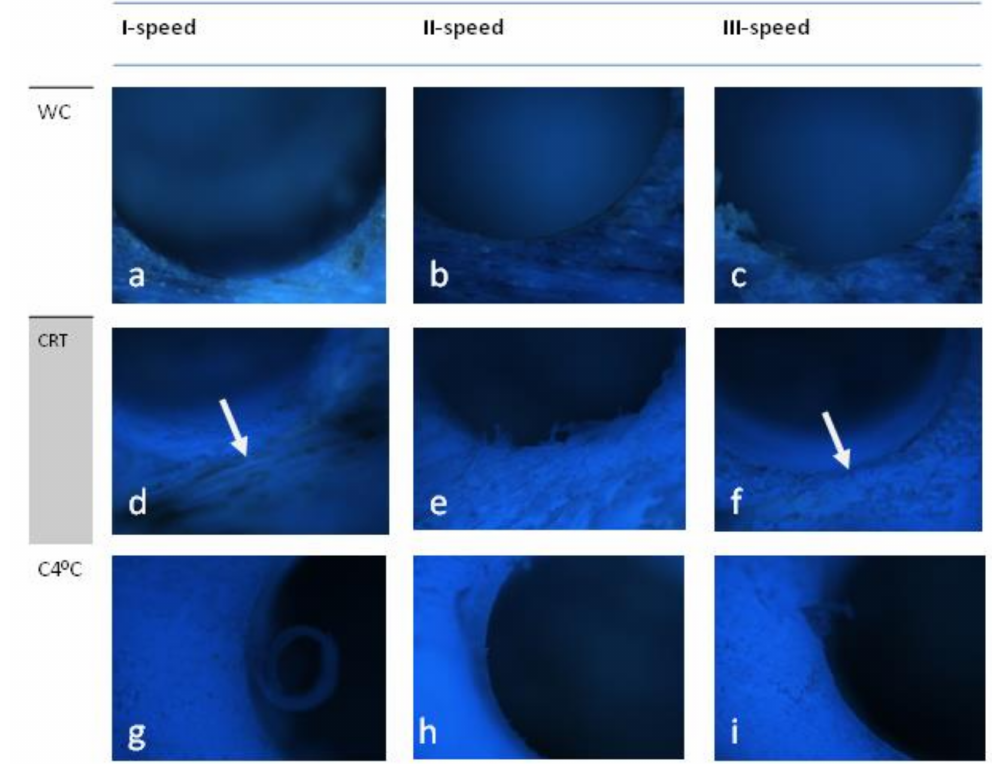
Figure 2. Drill-Osstem. The surfaces of holes drilled at different speeds (I-800 rpm, II-1000 rpm, III- 1200 rpm) and using different cooling methods. Note the different smoothness and different damage in the adjacent areas. WC-without cooling, CRT-cooling at room temperature, C4 ◦ C cooling at 4 ◦ C. Autofluorescence. Mag. x40. ( a – c ) WC-without cooling, ( d – f ) CRT-cooling at room temperature, ( g – i ) C4 ◦ C cooling at 4 ◦